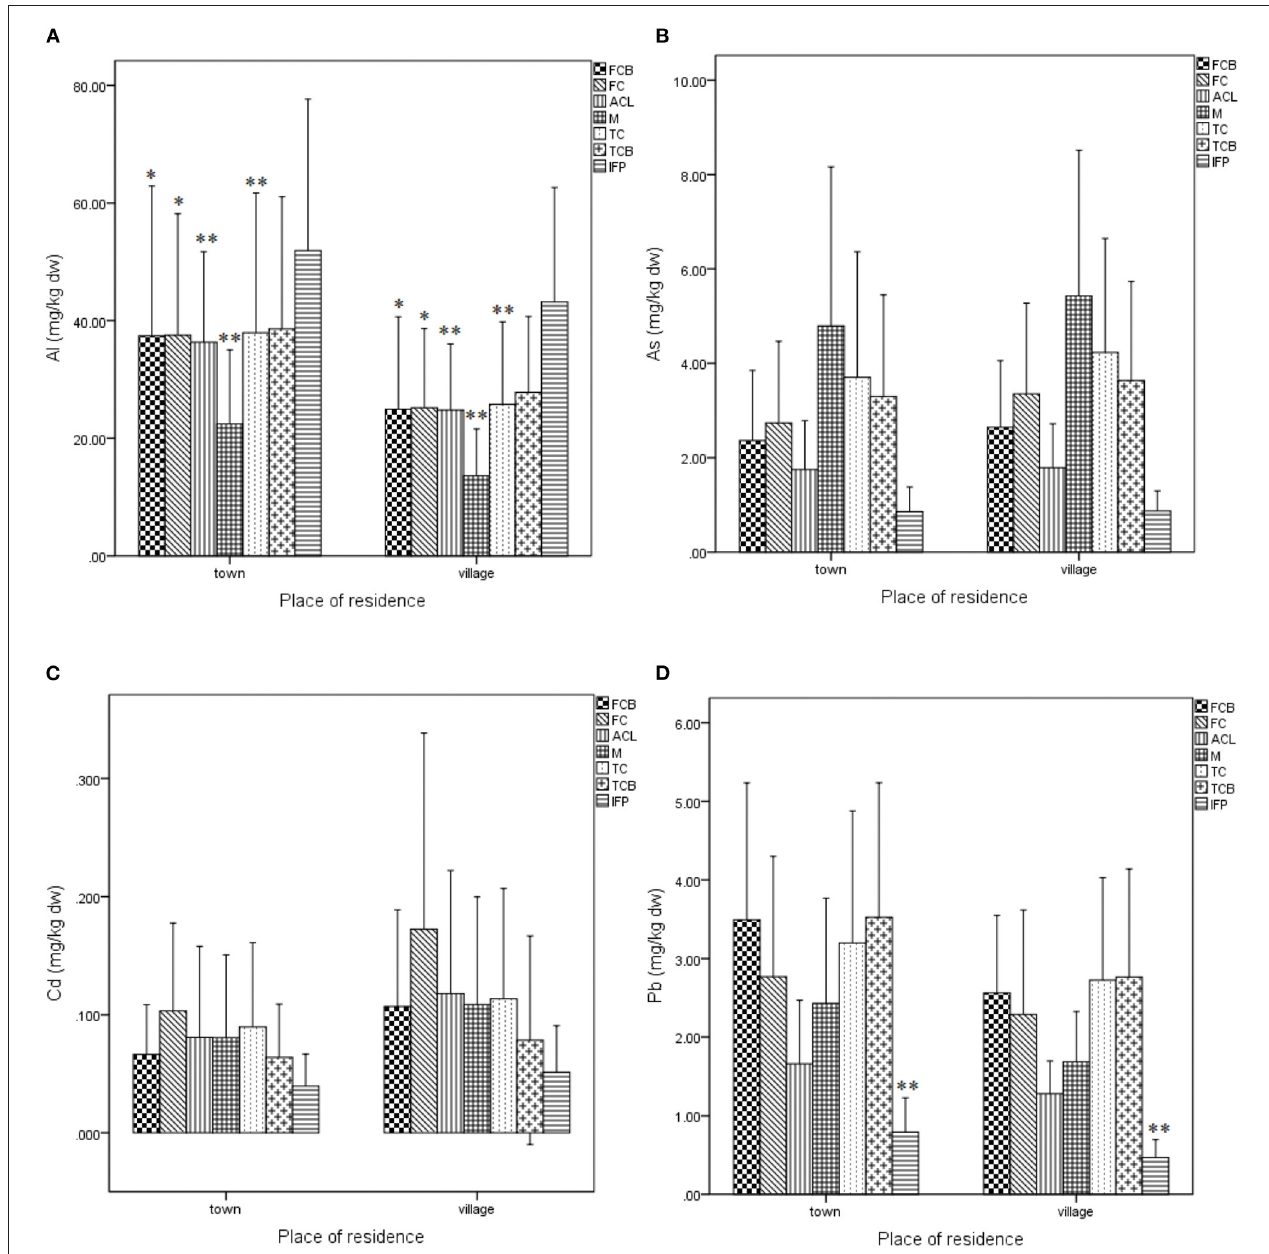
FIGURE 1 | The comparison of the aluminum, arsenic, cadmium, and lead concentrations with residents living in town and village. FCB, femoral cancellous bone; FC, femoral cartilage; ACL, anterior cruciate ligament; M, meniscus; TC, tibial cartilage; TCB, tibial cancellous bone; IFP, infrapatellar fat pad; mg/kg dw, mg/kg dry weight; * p < 0.05; ** p < 0.01. (A) Comparison of aluminum concentration between urban and rural patients. Al concentrations in the femoral cancellous bone, femoral cartilage, anterior cruciate ligament, meniscus, tibial cartilage in patients living in town were statistically significantly higher than in village at 37.41 vs. 24.93, 37.55 vs. 25.17, 36.34 vs. 24.80, 22.44 vs. 13.60, and 37.95 vs. 25.78 mg/kg dw, respectively. (B) Comparison of arsenic concentration between urban and rural patients. (C) Comparison of cadmium concentration between urban and rural patients. (D) Comparison of lead concentration between urban and rural patients. Pb concentration in the infrapatellar fat pad in patients living in town was statistically significantly higher compared to those residing in village at 0.79 vs. 0.47 mg/kg dw,